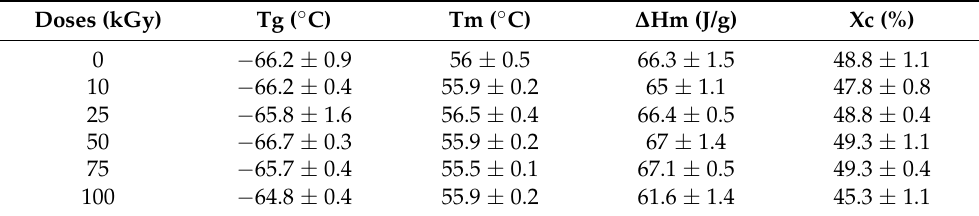
Table 2. Thermal properties obtained from DSC curves of PCL samples under EB radiation during the second heating